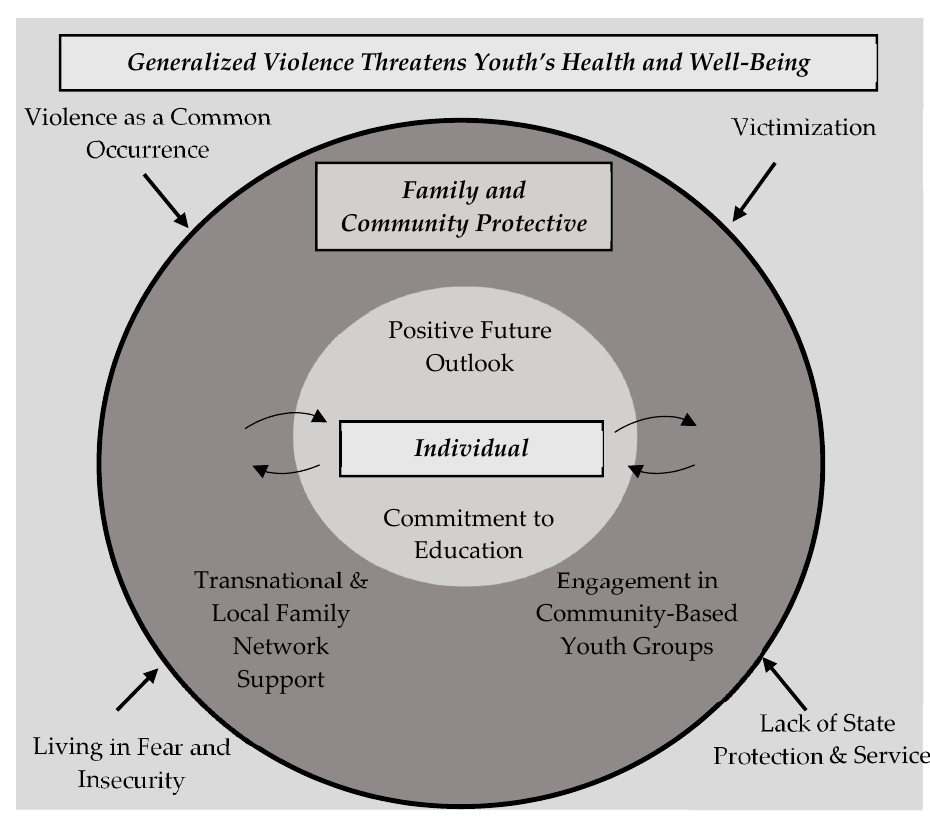
Figure 2. Conceptual Model: Generalized Violence, Family and Community Protective Factors, and Individual Resilience.